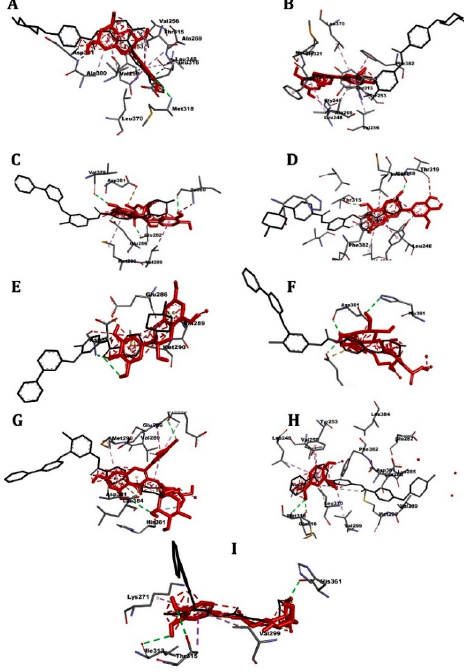
Figure 5. 3D scheme of the ligand-ABL kinase receptor interactions. In red, tested molecule ( A ) catechin, ( B ) epicatechin, ( C ) epicatechin gallate, ( D ) epigallocatechin, ( E ) gallocatechin, ( F ) oleuropein, ( G ) rutin, ( H ) vanillic acid, ( I ) chlorogenic acid; in black, reference molecule (nilotinib) and labeled